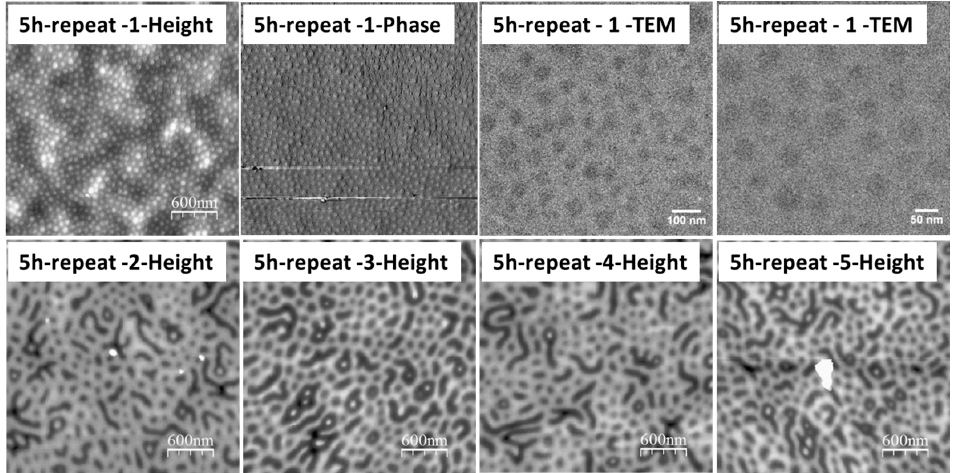
Figure 3. AFM surface profiles and TEM images of the 60-nm PS- b -P2VP thin films spin-coated at 3000 rpm from 1.5 wt % solution in toluene with further annealing under toluene vapor atmosphere at 50 °C for 5 h with several repeated experiments.